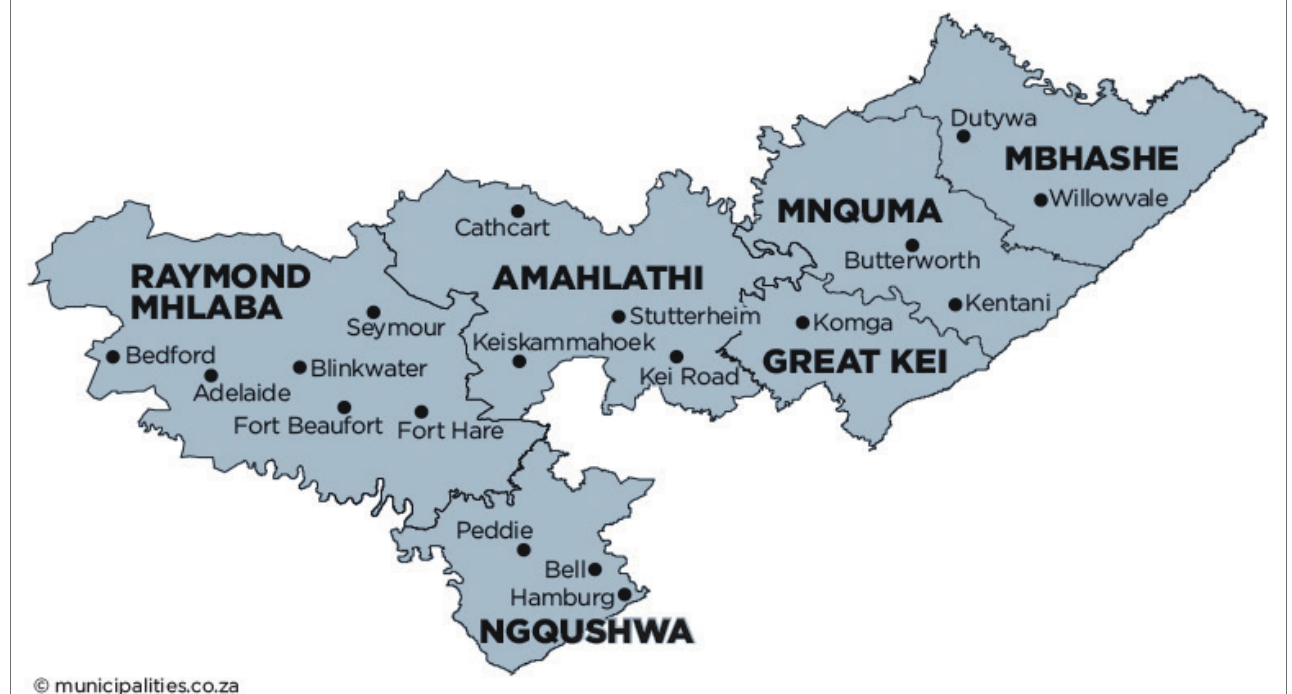
FIGURE 1: Amathole District Municipality, Eastern Cape Province, South Africa Study area